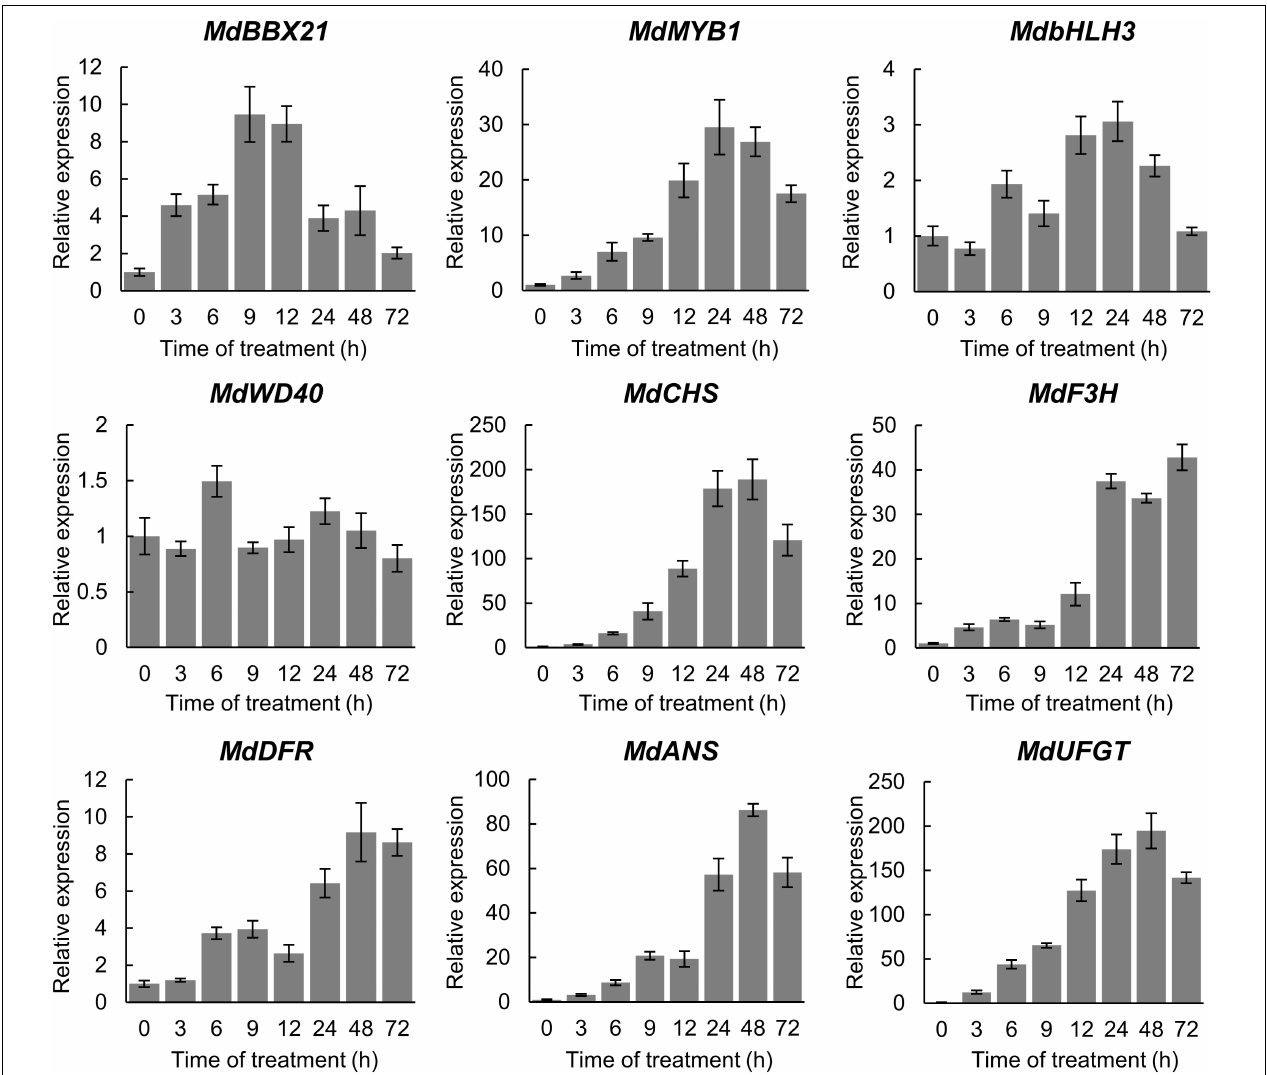
FIGURE 4 | Relative expression levels of anthocyanin biosynthesis-related genes in the apple fruit peel irradiated with white light. The MdActin gene was used as the internal